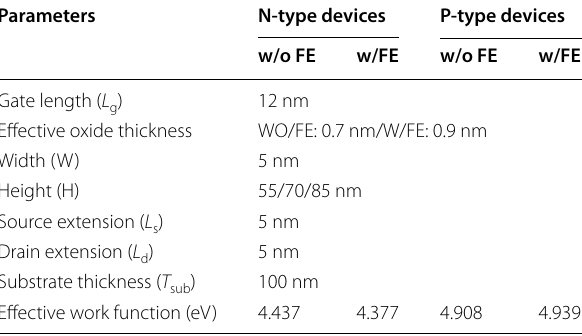
Table 2 The adopted device parameters of N‑/P‑type GAA and NC‑GAA FinFETs, where the fin heights are 55, 70 and 85 nm